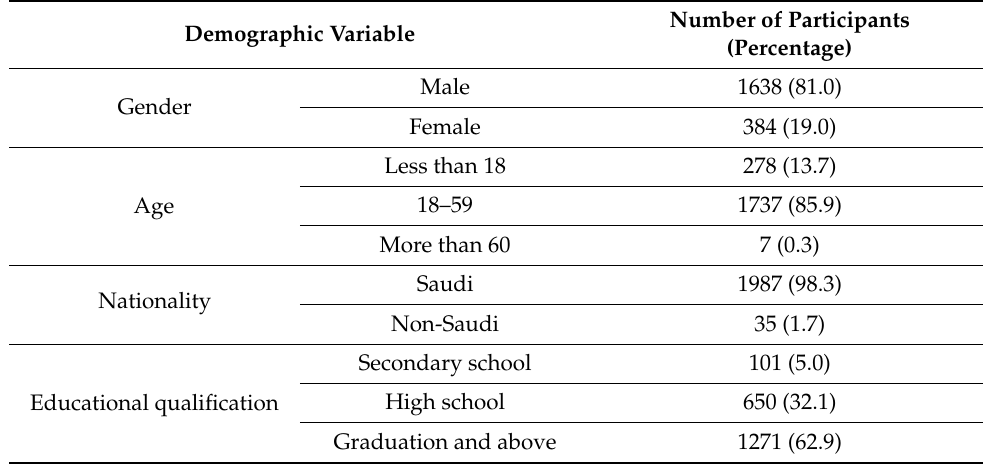
Table 1. Demographic characteristics of the participants.